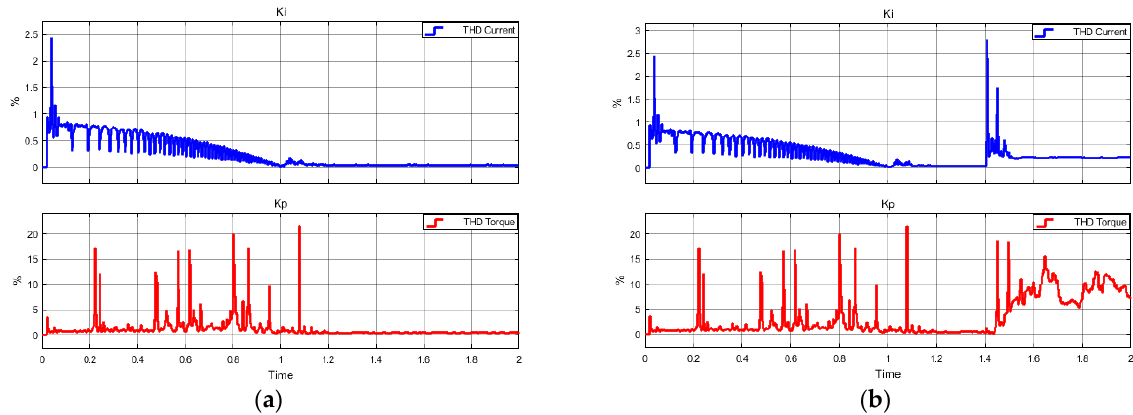
Figure 2. Oscillograms for the output coordinates of the electric motor.